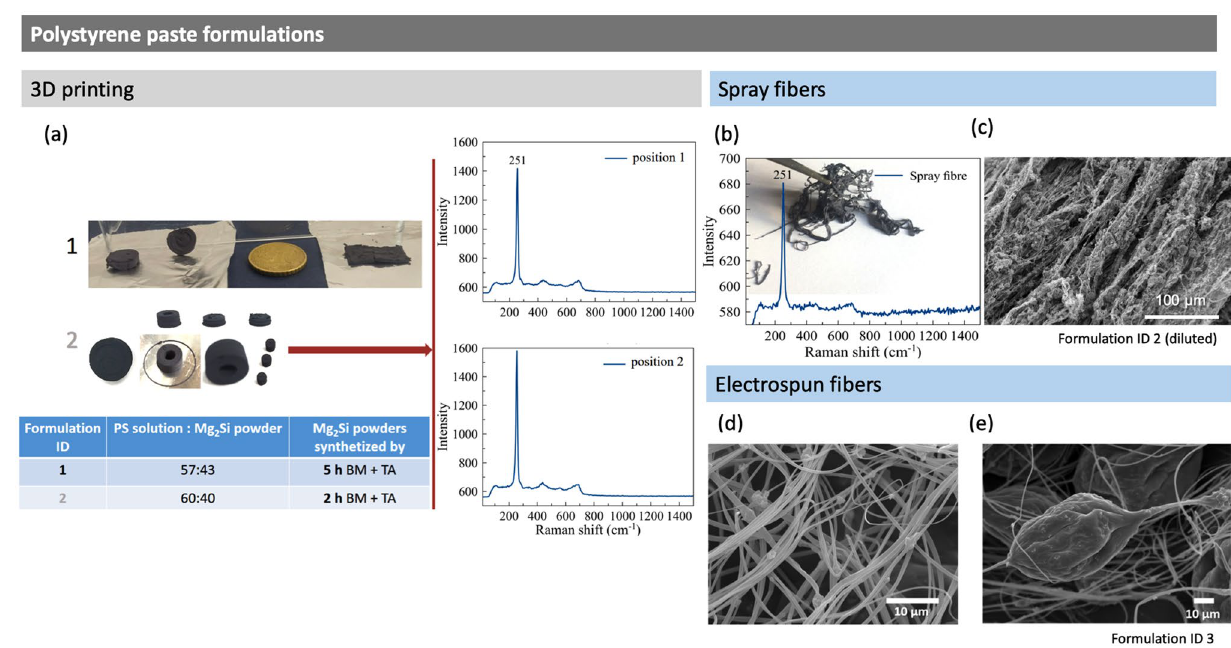
Fig. 5 a Pieces printed with Mg 2 Si pastes following formulations 1 and 2 and SEM images of sprayed ( b , c ) and electrospun PS/Mg 2 Si fibers ( d , e ) produced with paste formulations 2 and 3, respectively. 3D-printing formulations are specified in Table 2